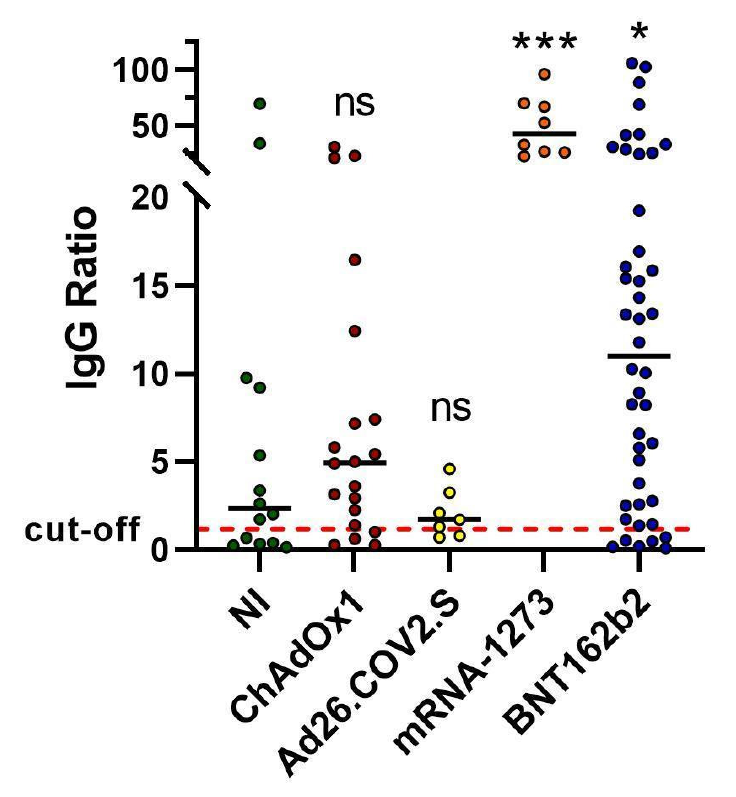
Figure 1. Antibodies elicited by resolved natural infections and COVID-19 vaccines. Comparison of longitudinal SARS-CoV-2 spike IgG levels among resolved natural infections (NI) and ChAdOx1, Ad26.COV2.S, mRNA-1273, and BNT162b2 COVID-19 vaccines were carried out. Individual data points are represented as scatter dot plots with lines showing the median value (cutoff value = 1.2).